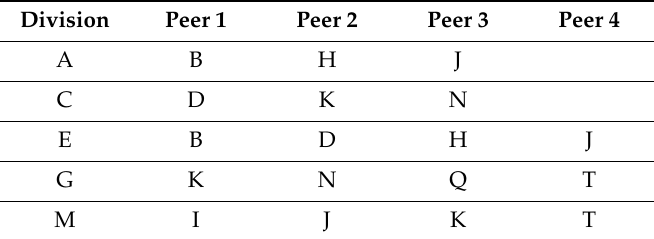
Table 3. Peer relationships for ine ffi cient